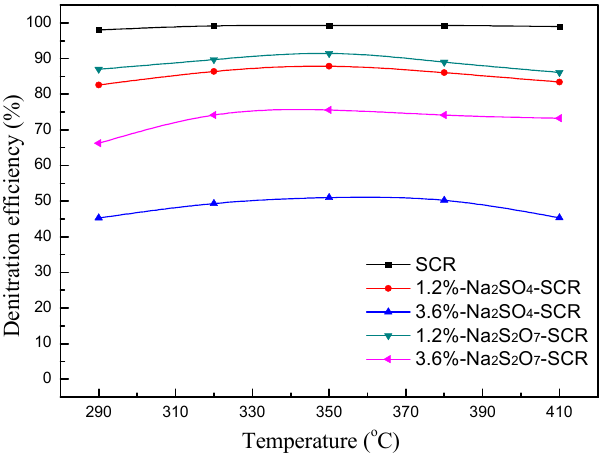
Figure 3. Effect of temperature on NO conversion. Reaction conditions: 500 ppm NO, 500 ppm NH 3 , 5% O 2 , 2% H 2 O, total flow gas 1.5 L/min, and gas hourly space velocity (GHSV) = 45,000 h − 1 .